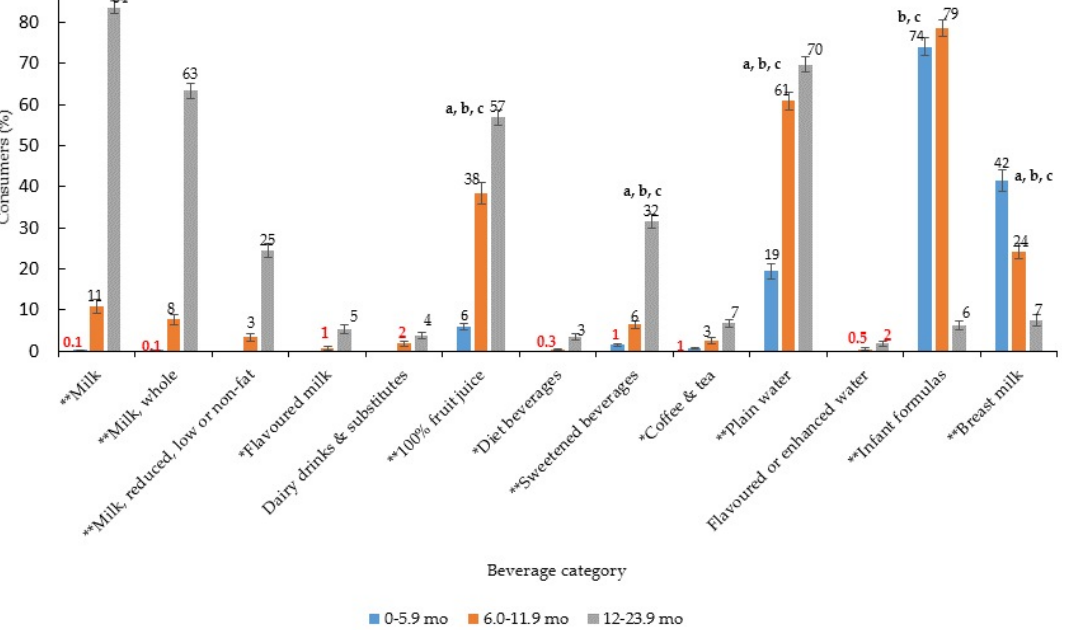
Figure 1. Proportion (%) of children consuming each type of beverage by age group ( n = 2740) 1,2,3,4,5 . 1 Error bars represent ± 1 SE. Those bolded in red are statistically unreliable, relative standard error ≥ 30% [24]; 2 Chi ‐ square test to assess difference in proportions, * p < 0.01, ** p < 0.001. Where significant,